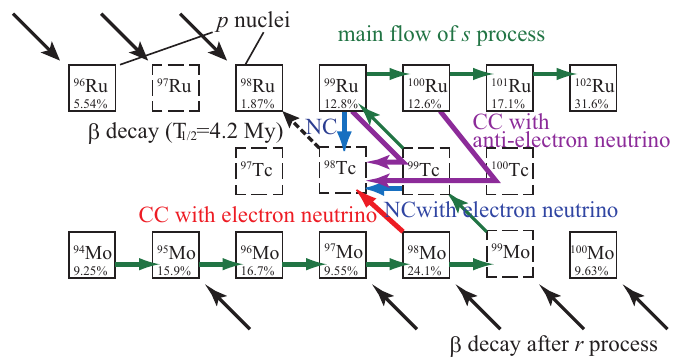
Figure 2. Nucleosynthesis flow and key nuclear reactions around 98 Tc